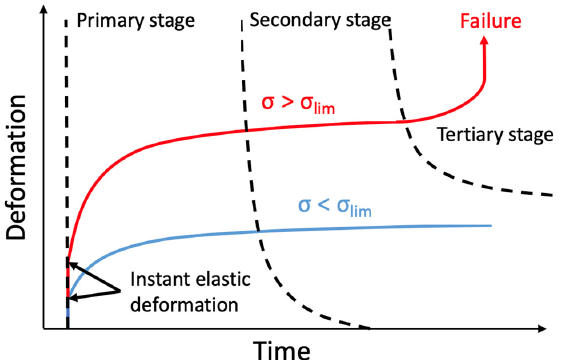
Figure 1. Creep deformation of timber under load. σ = applied load stress, σ lim = ultimate stress limit [19].